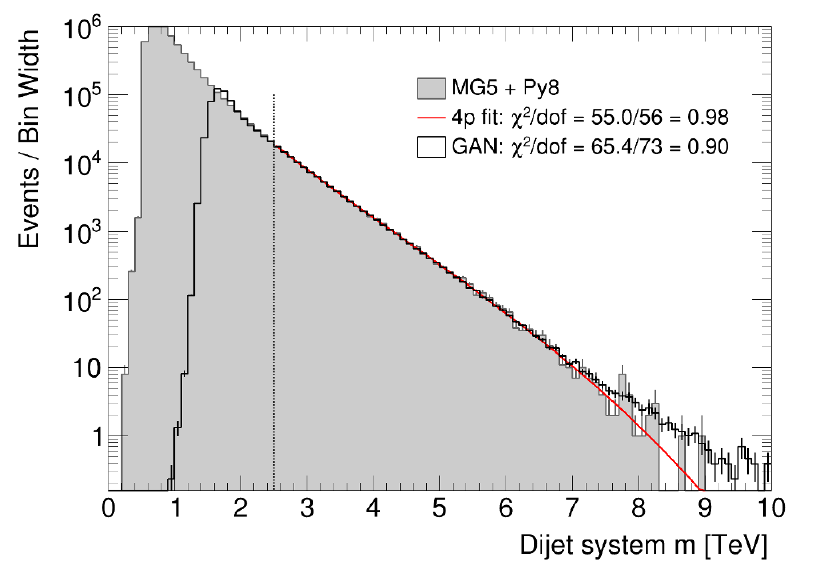
Figure 7 . Comparison between a ( MadGraph5 + Pythia8 ) Monte Carlo simulation sample and the GAN extrapolation to high dijet invariant mass. The gray area represents the MC prediction, the black line indicates the GAN output, and the red line is the (cid:12)tted four-parameters analytic